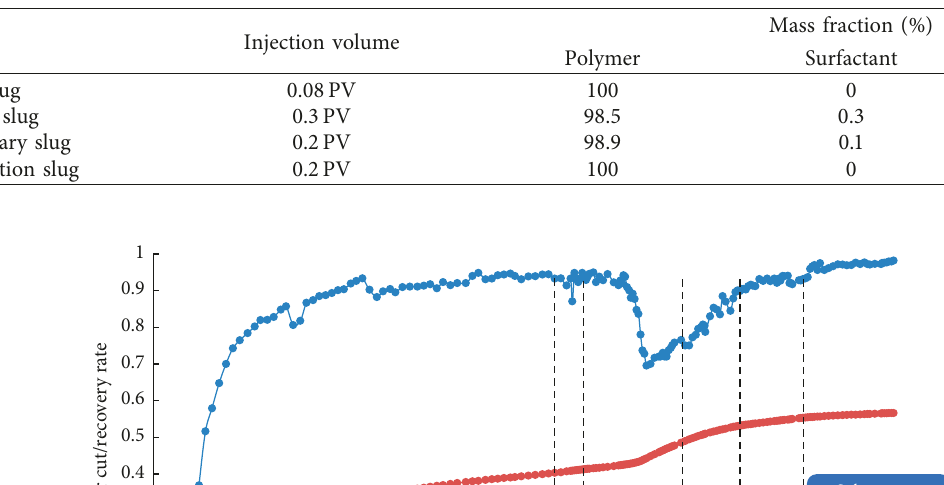
Table 3: Formula of each slug in ASP flooding.